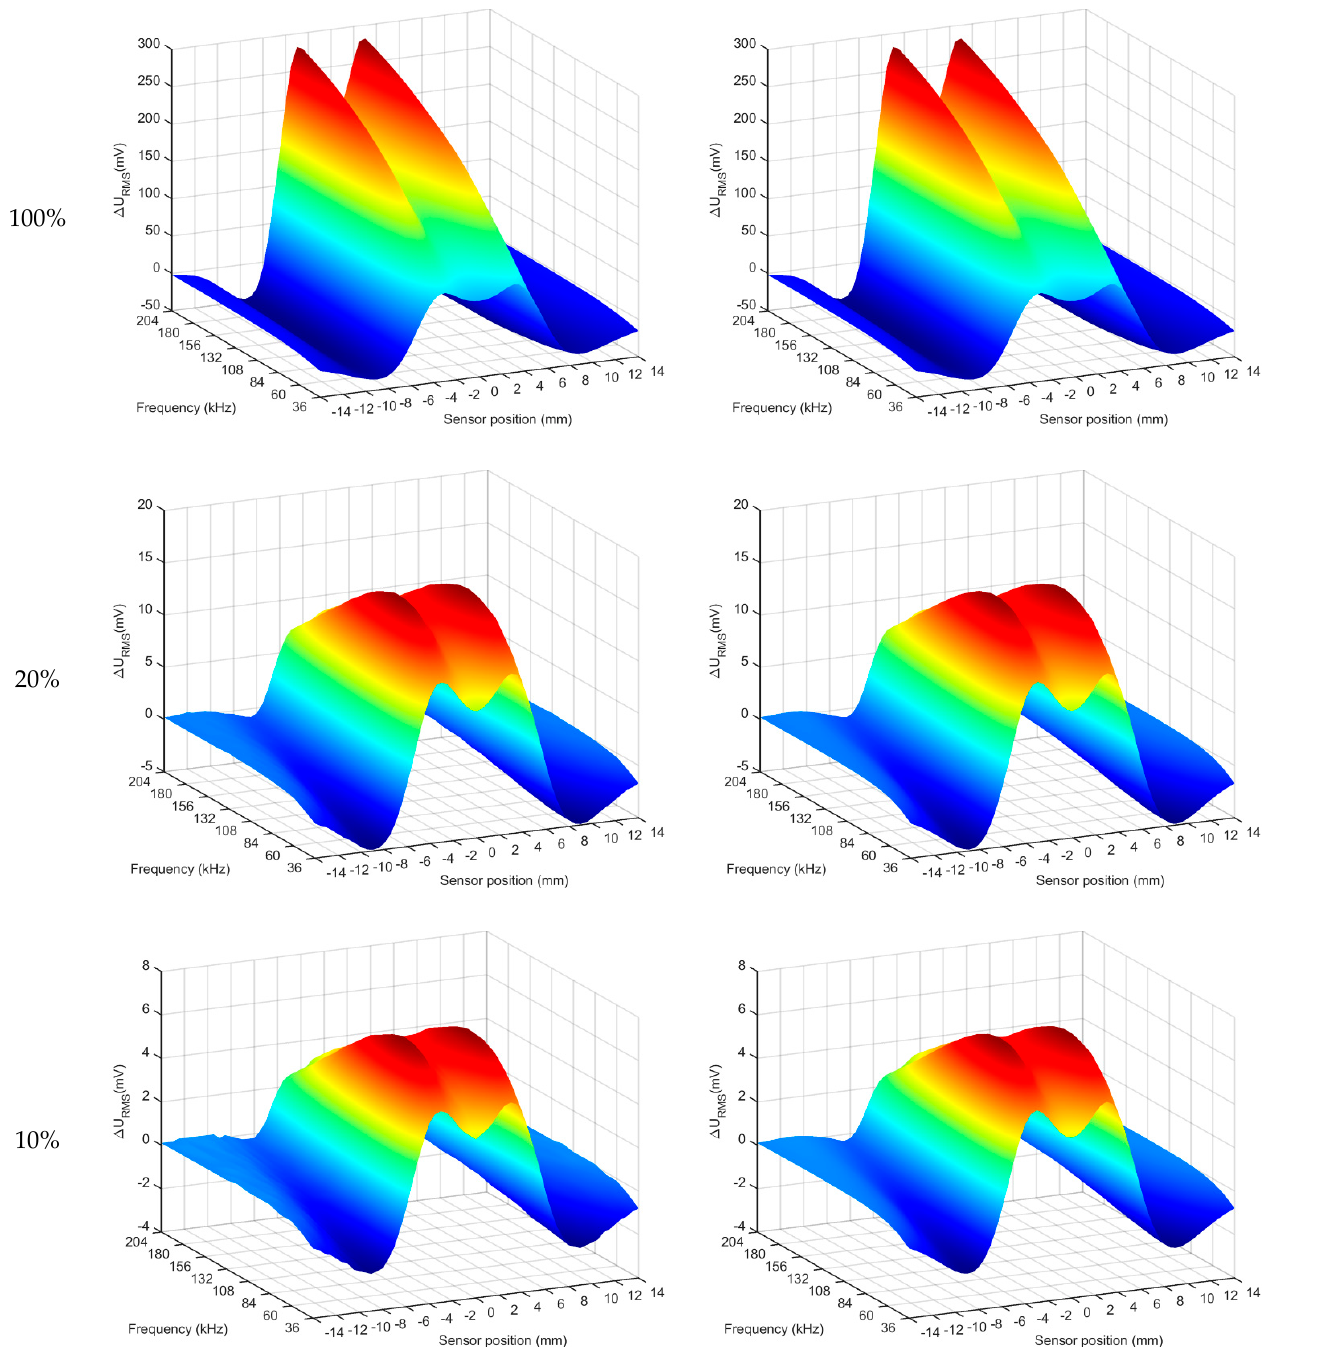
Figure 13. Comparison of spectrograms achieved from two methods MFES-ECT and PMFES-ECT, for various flaws depth. For each defect depth for each method, the (cid:1858) (cid:3014)(cid:3002)(cid:3025) , (cid:1876) (cid:3014)(cid:3002)(cid:3025) and (cid:1845) (cid:3014)(cid:3002)(cid:3025) parameters were almost identical. Both methods in the simulation environment provide the same results and enable precise estimation of the length and depth of a defect, and therefore can be used interchangeably.